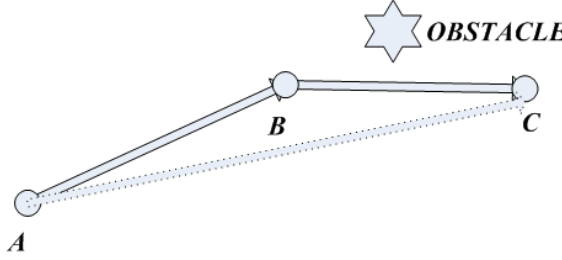
Figure 8. Diagram of the redundant nodes.